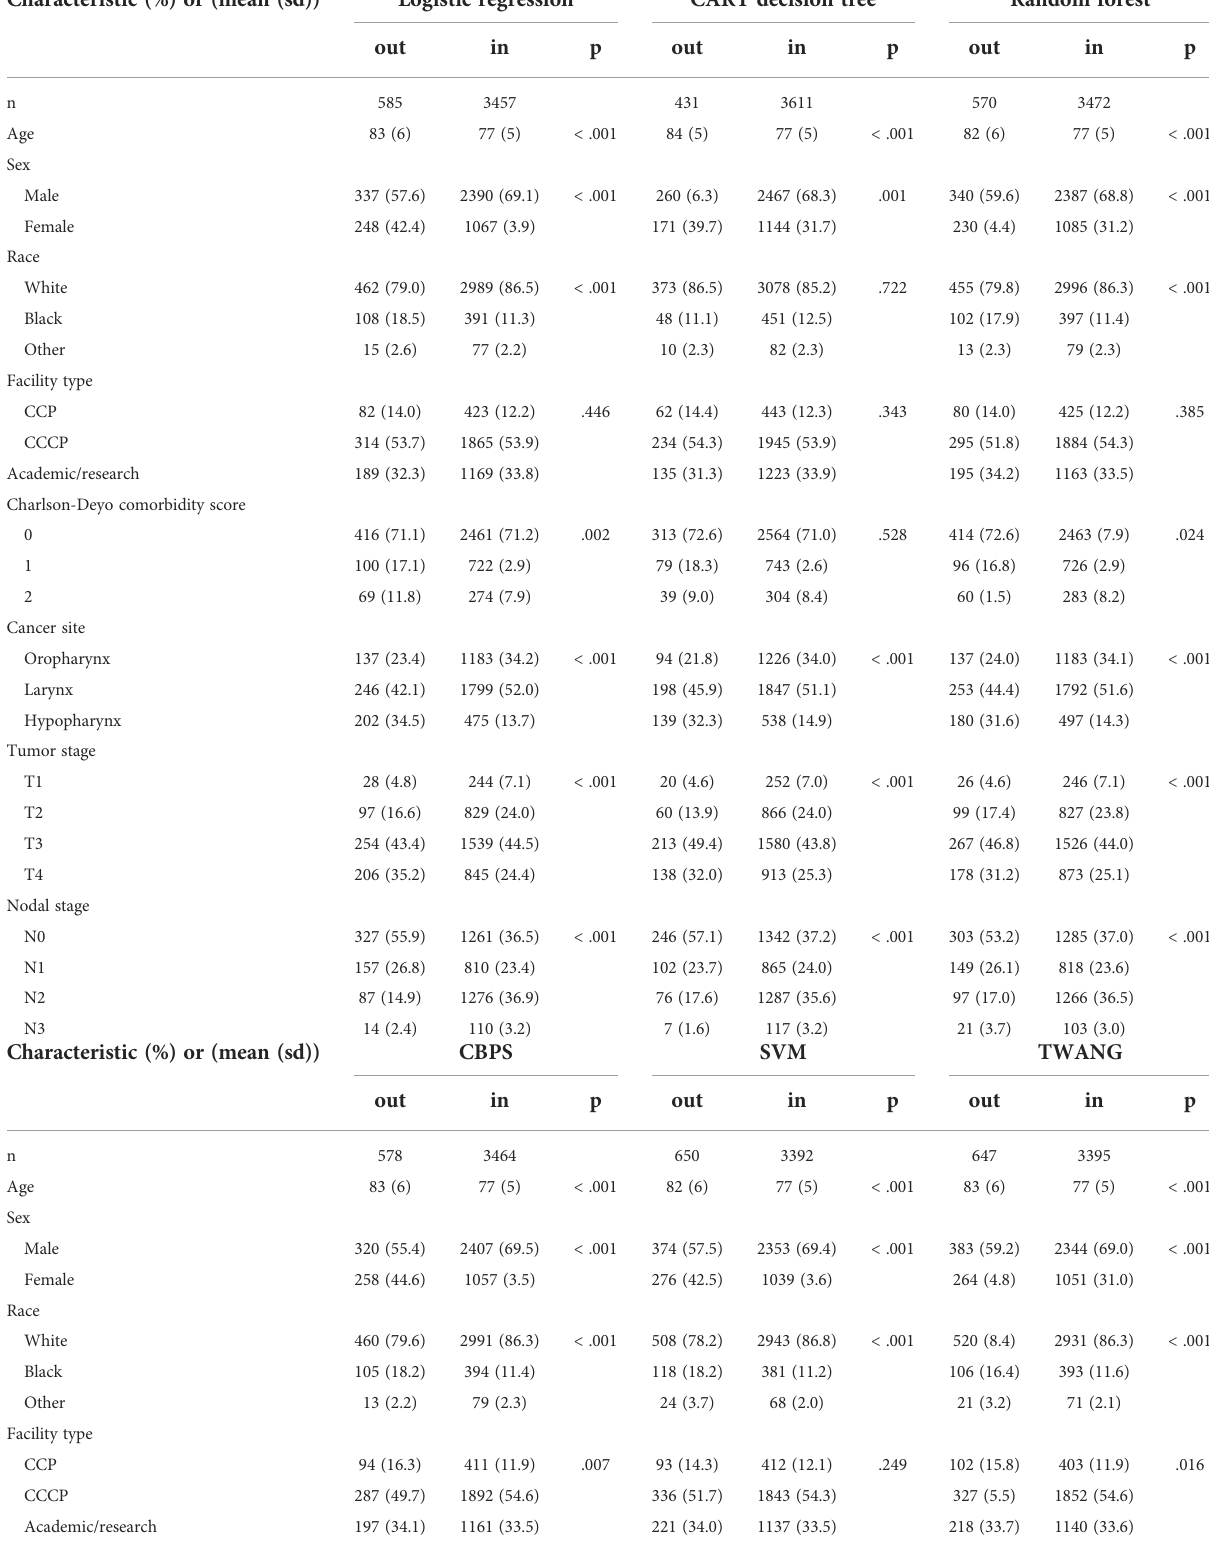
TABLE 1 Head and neck cancer patient characteristics by match status for given propensity score method. Characteristic (%) or (mean (sd)) Logistic regression CART decision tree Random